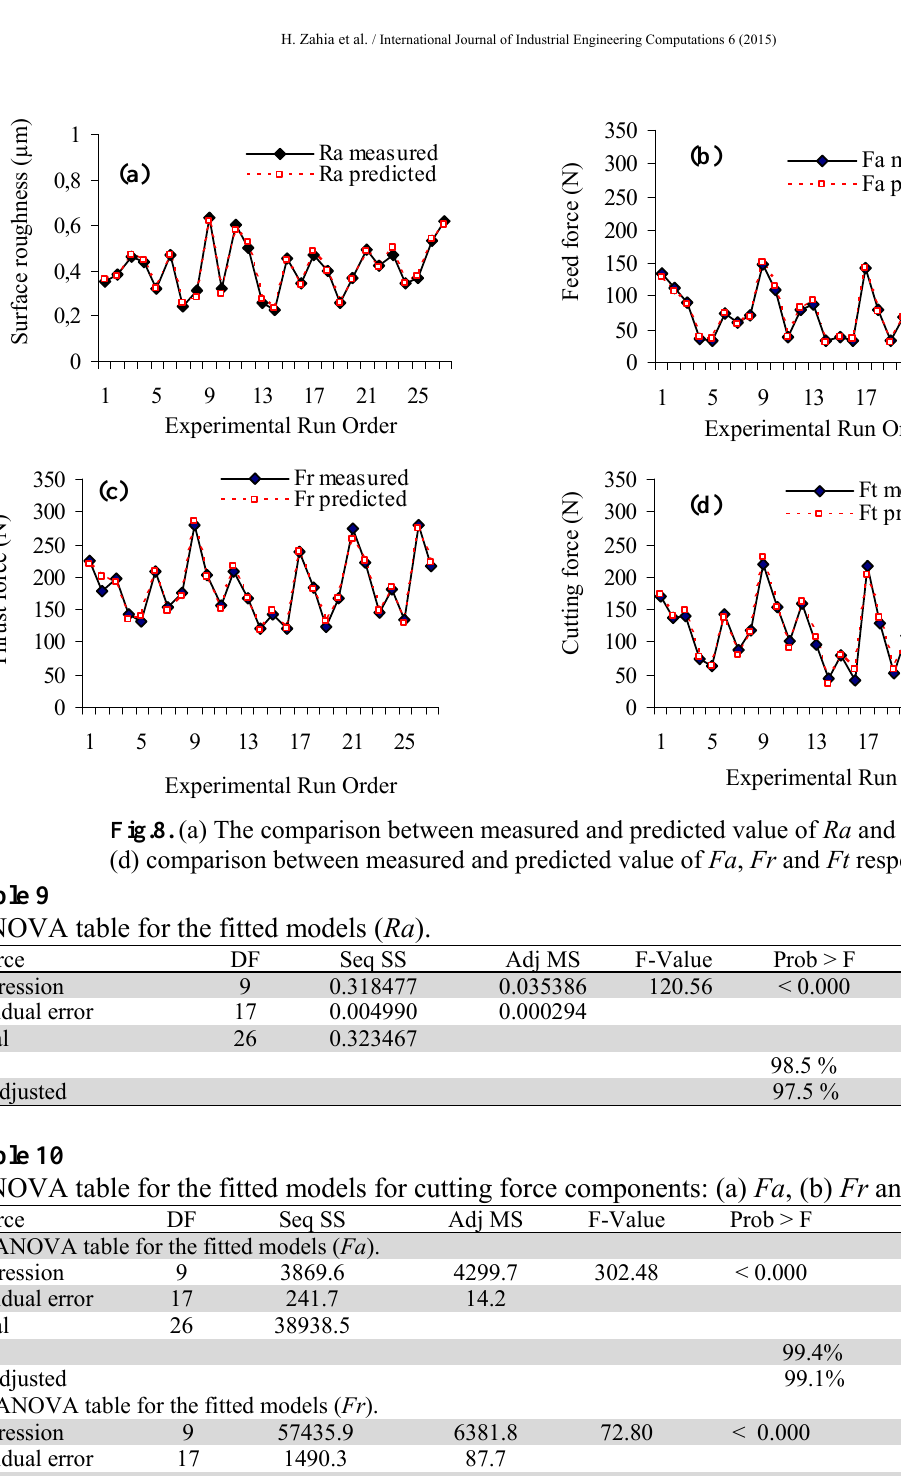
(c) ANOVA table for the fitted models ( Ft ).